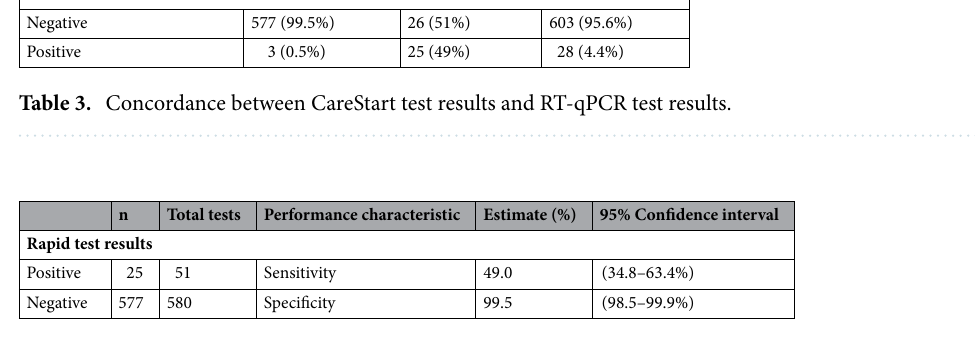
Table 4. Performance characteristics of CareStart test results benchmarked against the RT-qPCR gold